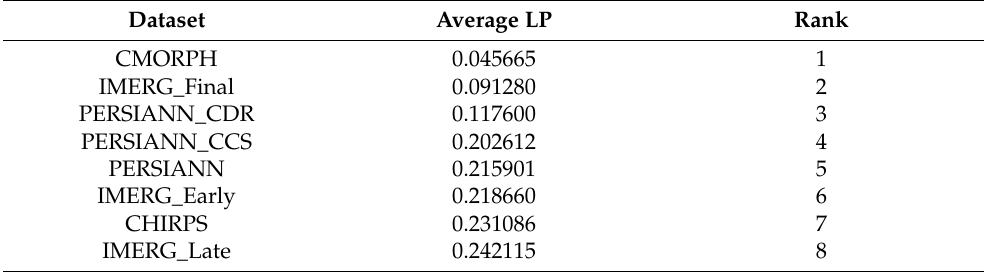
Table 2. The assigned rank of SPPs based on categorical (POD, FAR, ACC, and CSI) and continuous (RSME, CC, PBIAS, and MAE) variables performance indicators on a daily time scale by employed compromise programming MCDM for Simat Khola River Basin, Nepal, as a representative region of morphological complex Himalayan